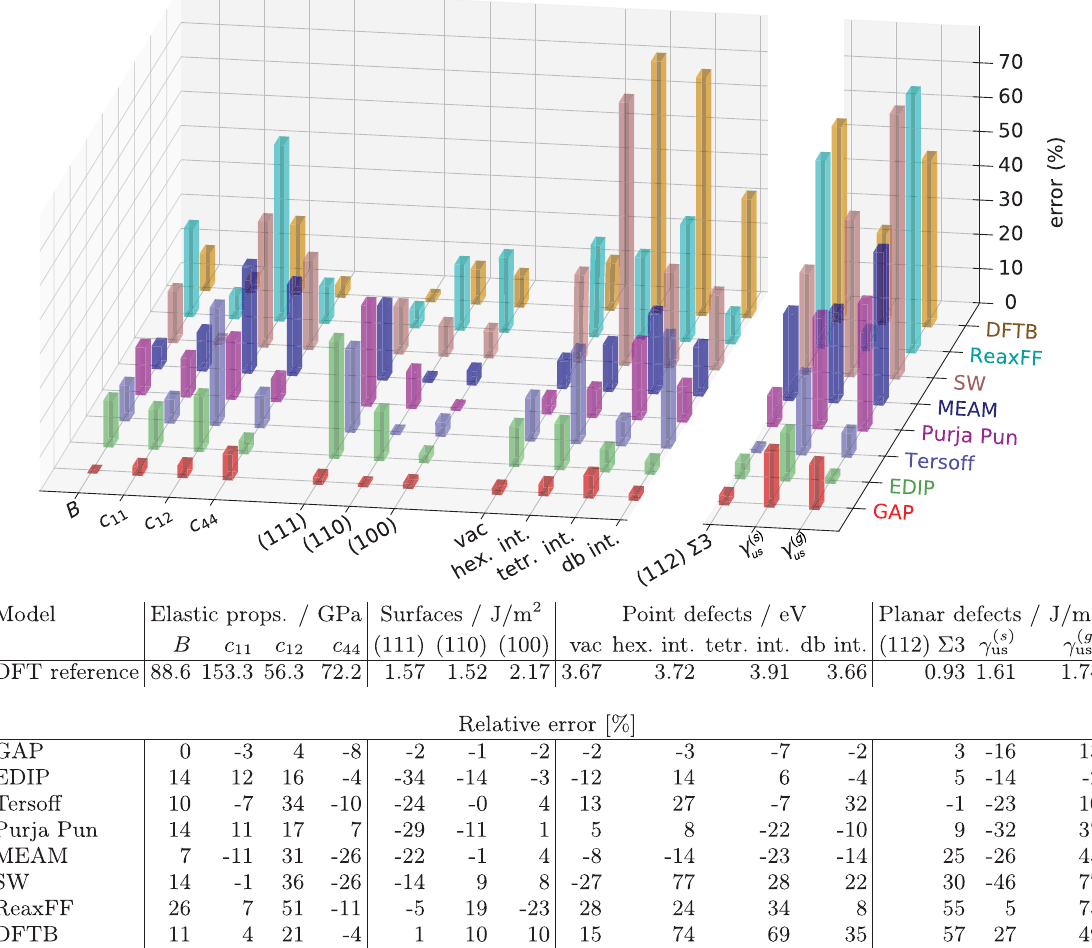
FIG. 1. Comparison of percentage errors made by a range of interatomic potentials for selected properties, with respect to our DFT reference. Those on the left of the break in the axis are interpolative, i.e., well represented within a training set of the GAP model: elastic constants (bulk modulus B , stiffness tensor components C ), unreconstructed (but relaxed) surface energies [(111), (110), and (100) ij low-index surfaces], point-defect formation energies (vacancy and hexagonal, tetrahedral, and dumbbell interstitials); while the planar defects to the right are extrapolative: (112) Σ 3 symmetric tilt grain boundary and unstable stacking-fault energies on shuffle plane γ ð g Þ and glide plane γ us . The first row in the corresponding table shows reference quantities computed with the DFT (units indicated in the header